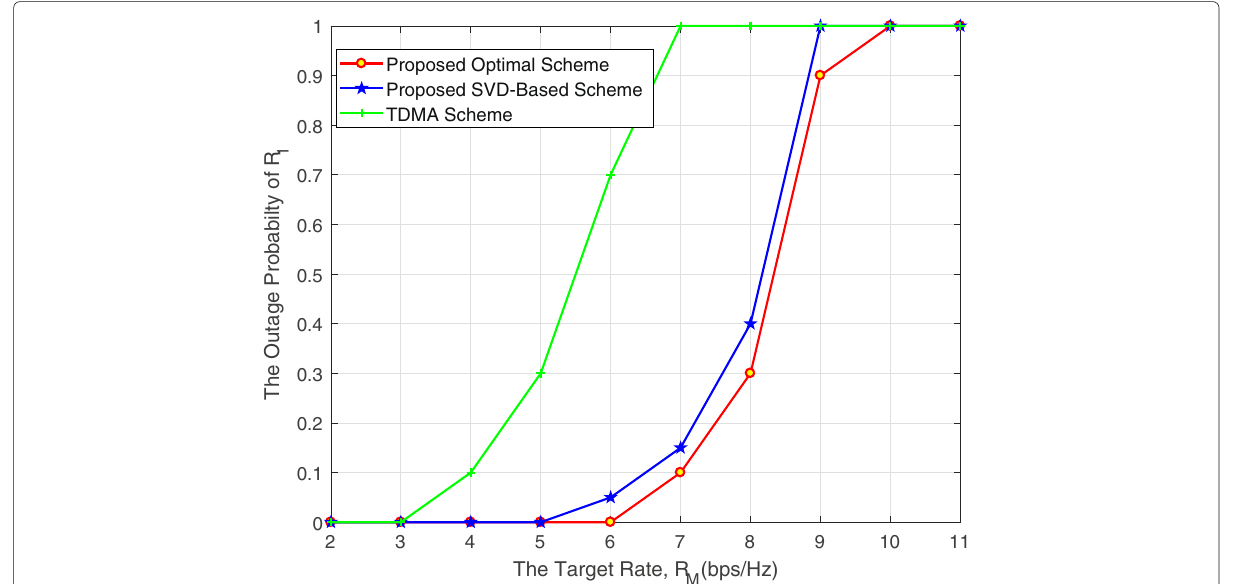
Fig. 5 Simulation 4. The outage probability of R 1 versus R M for different schemes with N =4 and P = 25